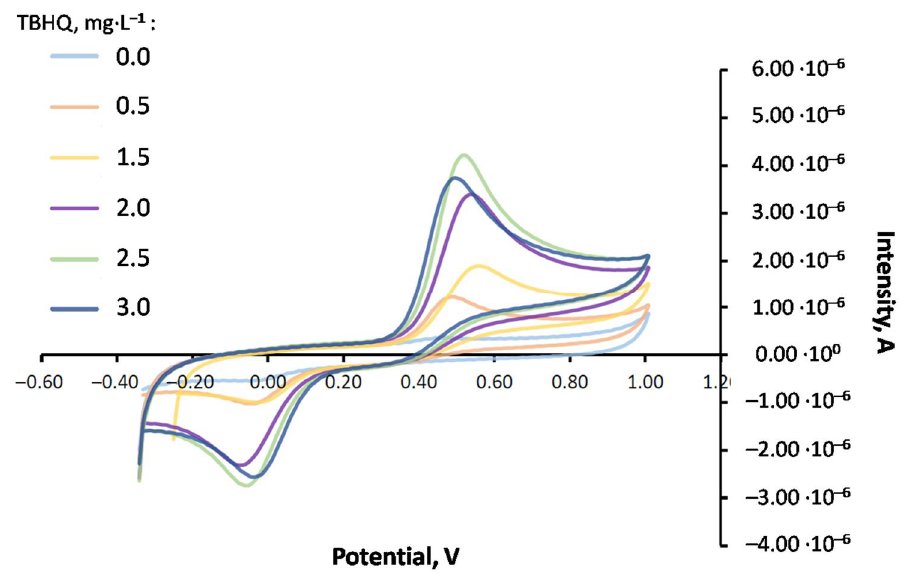
Figure 11. Cyclic voltammograms with different standard additions obtained through dispersive extraction for FOBL and Op. TBHQ (2114 mg·L −1 ) after 1 h of oxidation.